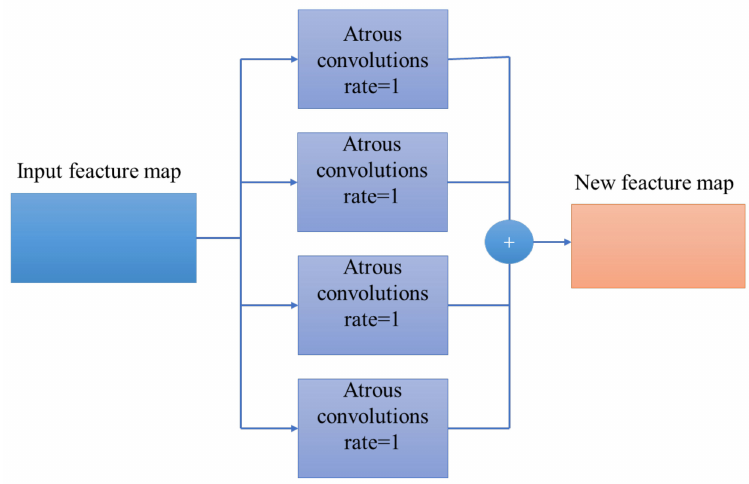
Figure 5. Schematic diagram of obtaining features of different